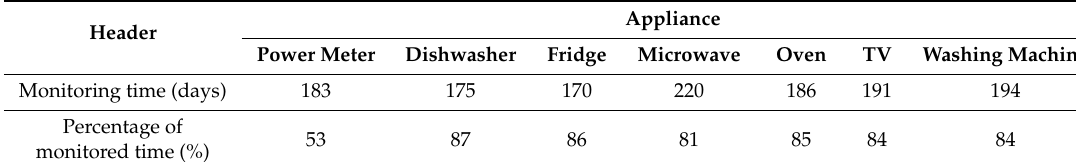
Table 6. Average monitoring time by appliance.